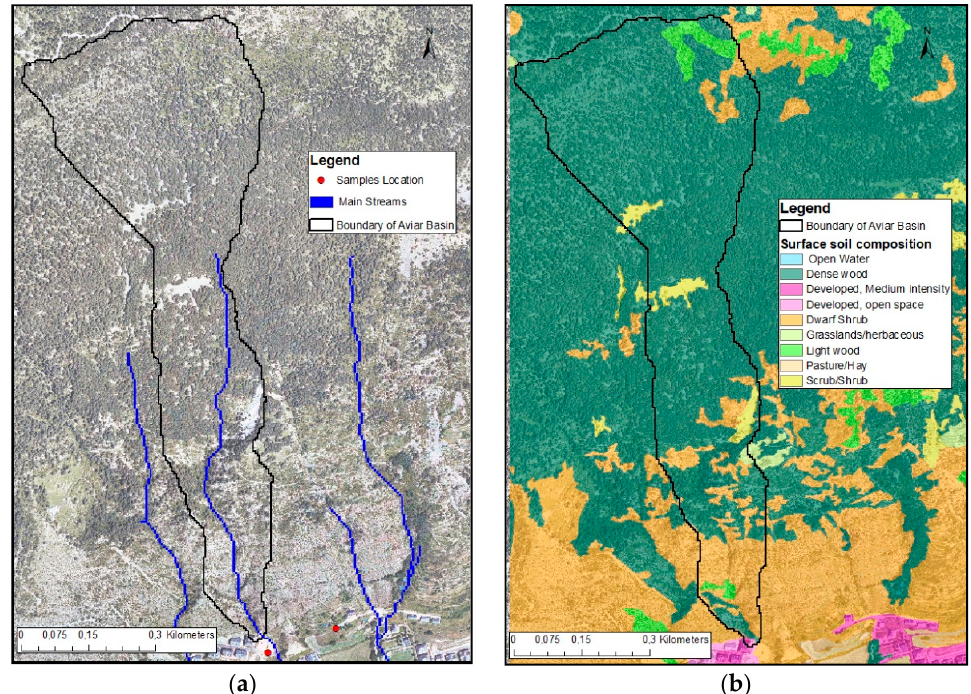
Figure 2. Study area description: ( a ) Study area and sample location, ( b ) surface soil composition map from Sigma (http://iea.ad/sigma, accessed on 17 December 2013) [3].